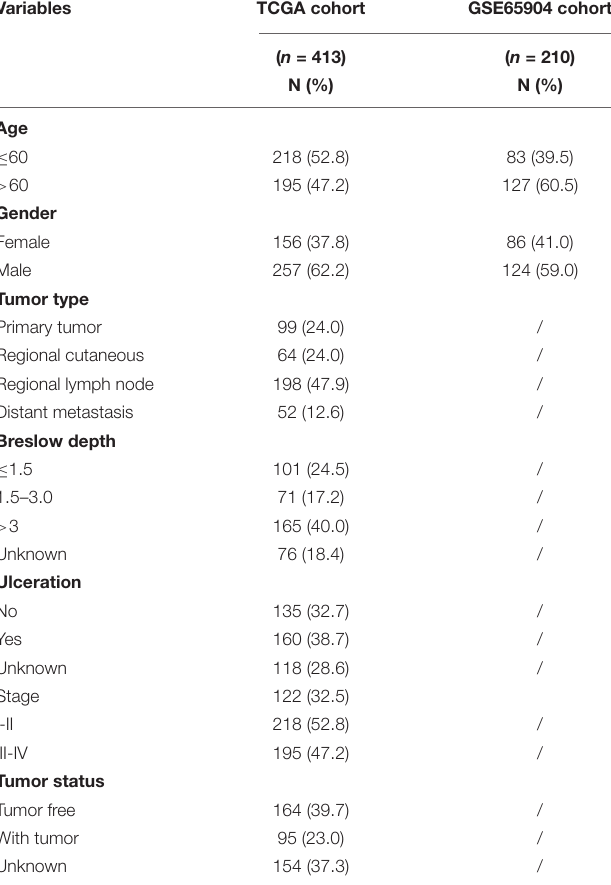
TABLE 1 | Clinicopathologic characteristics of melanoma patients in TCGA and GEO cohorts.